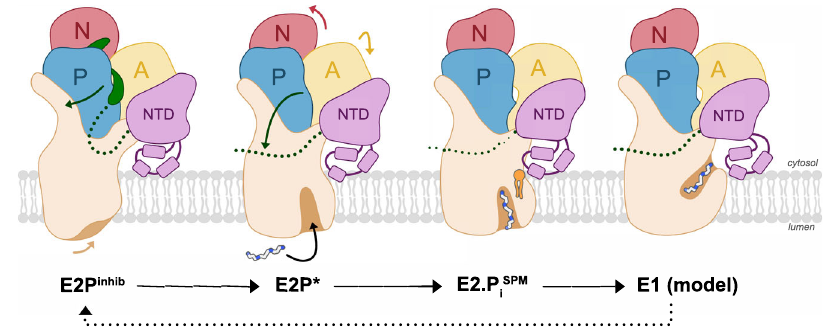
Fig. 4 Proposed transport mechanism. We suggest P5B-ATPases rest in a phosphorylated state, auto-inhibited through interactions of N-terminal residues with the cytosolic A-, P-, and N-domains (E2P inhib ). Polyamine binding and the coupled dephosphorylation lead to the release of the auto- inhibitory loop, and the formation of a binding pocket between TM 2, 4, and 6 (E2P*). It is possible that the formation of the cavity and polyamine uptake may be stimulated through interactions of the NTD with a regulatory lipid (E2.P i SPM , orange). Dephosphorylation and the subsequent E2 → E1 transition will then lead to cargo release to the cytosol, priming the ATPase for nucleotide binding, phosphorylation, and a new